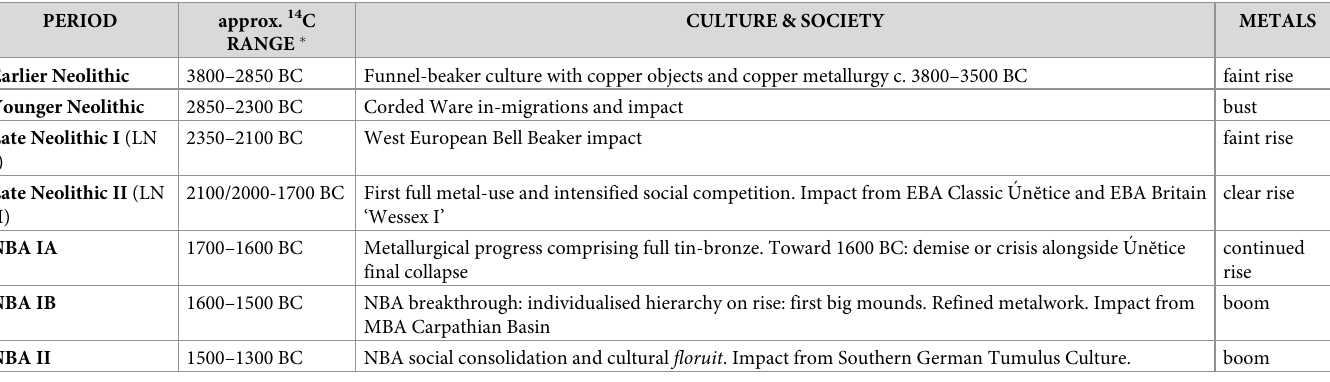
Table 1. The generally accepted chronological phasing rests on a combination of object typologies, object assemblages in hoards and burials, and 14 C ranges.